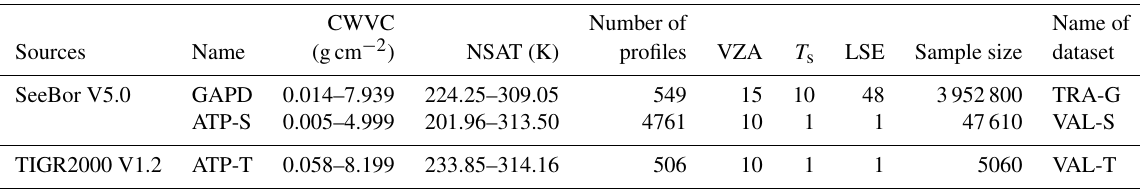
Table 3. Atmospheric profile datasets and corresponding simulation datasets.